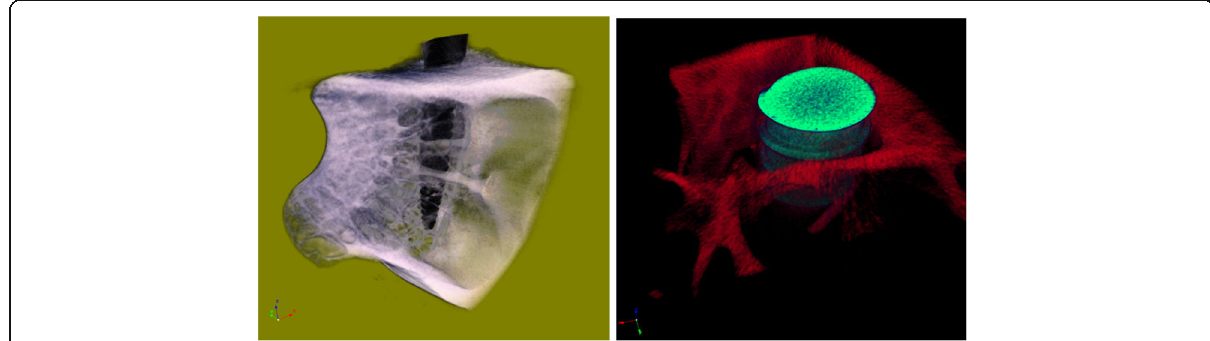
Fig. 6 Micro CT scan images of the MDIs and Ankylos ® embedded in rabbit bone 6 weeks post